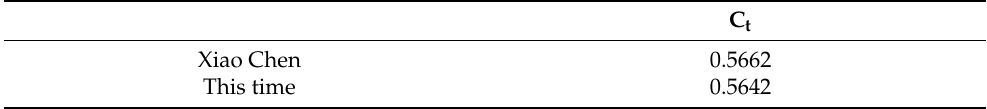
Table 1. Numerical Verification of Computational